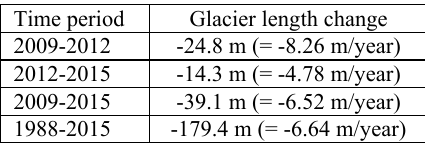
Table 8. Glacier length